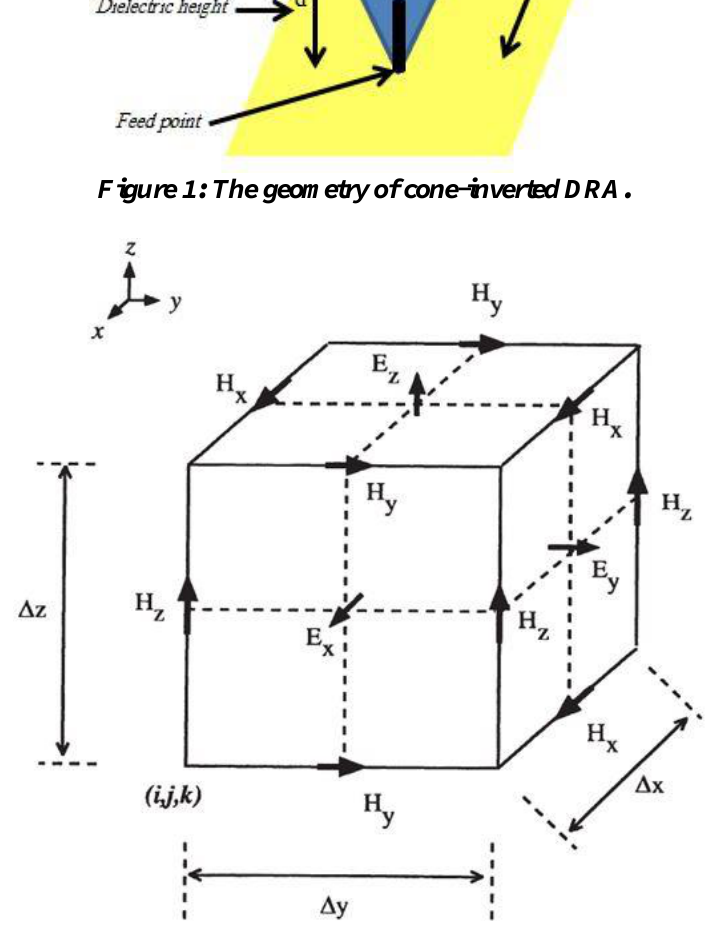
Figure 2: Yee's cell FDTD in